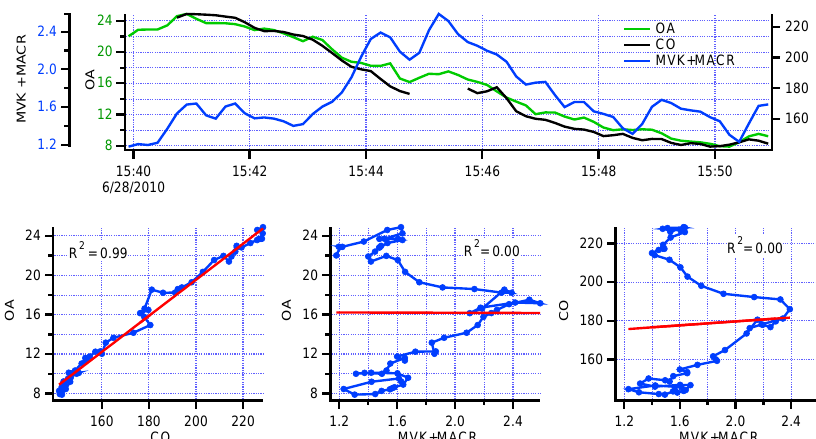
Figure 6. Flight 628b T1 transect. Same format as Fig. 4.